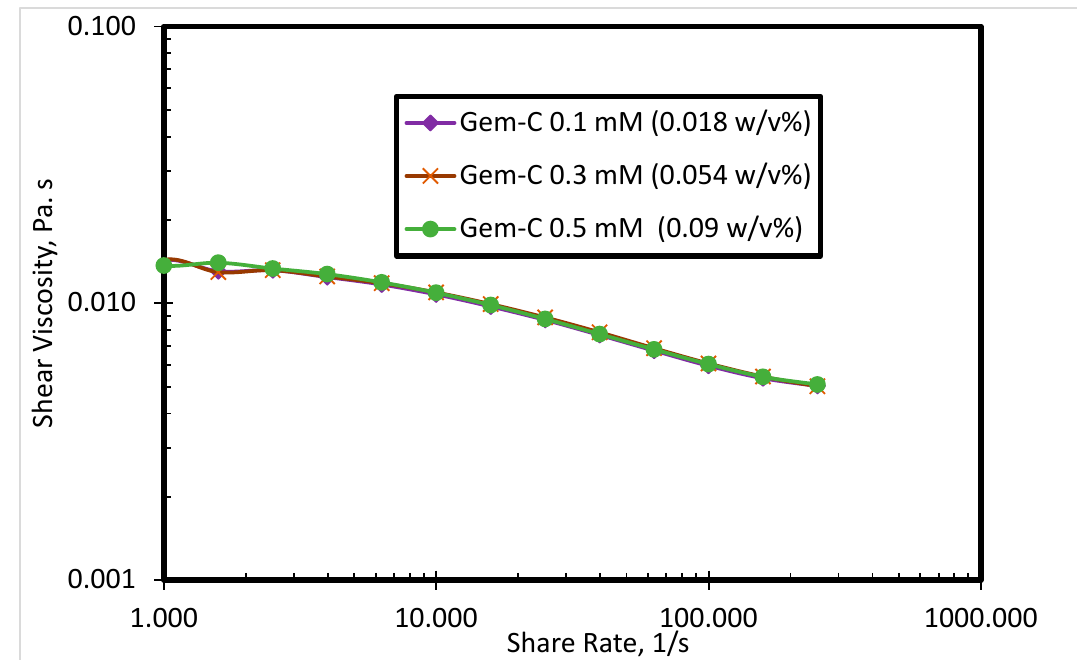
Figure 4. Shear viscosity of Gem-C at different concentrations in seawater.